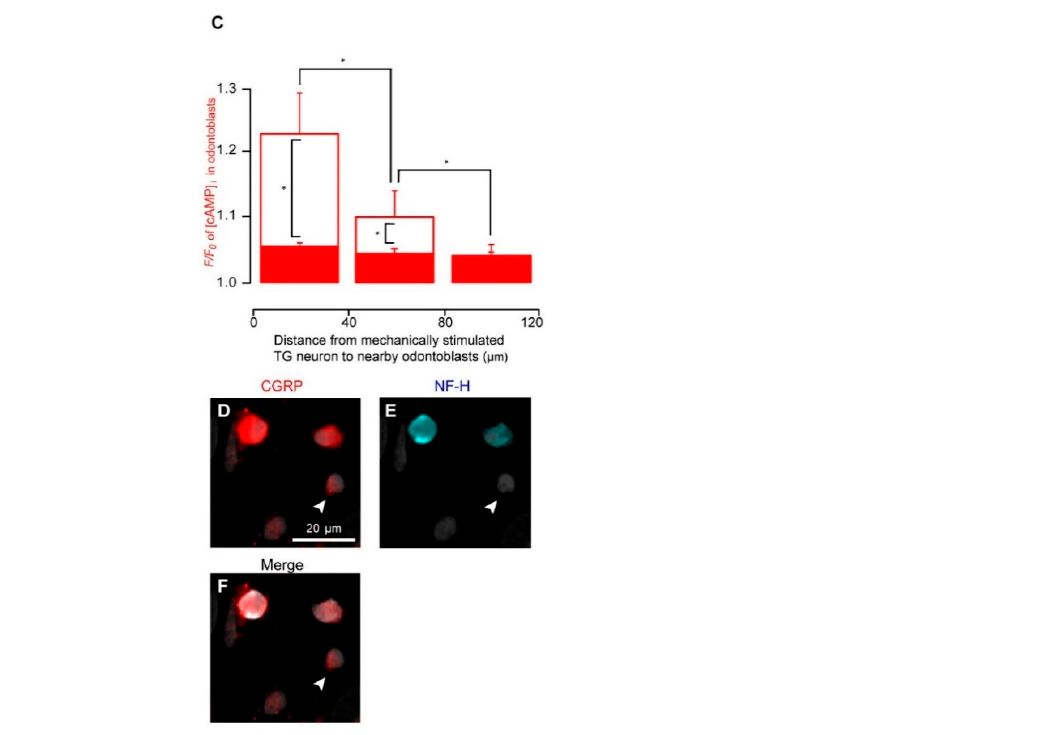
Figure 5. Direct mechanical stimulation of TG neurons simultaneously increases [Ca 2+ ] i in neu- rons and [cAMP] i in the neighboring odontoblasts. ( A , B ) Representative traces showing transiently increased [Ca 2+ ] i in a mechanically stimulated TG neuron (green lines) and [cAMP] i level in neigh- boring odontoblasts (red lines) following focal and direct mechanical stimulation by a micropipette under standard extracellular solution. The traces shown are without ( A ) or with 0.1 nM BIBN 4096 ( B ). Horizontal dotted lines indicate the baseline ( F / F 0 = 1.0) for each response, while vertical dotted lines represent the application time of the mechanical stimulation. The black boxes at the top show the timing of the mechanical stimulation based on the displacement of a micropipette to a depth of 8 µ m. The responses from the nearby odontoblasts were recorded from cells located 0–120 µ m away from the stimulated TG neuron. The distance of each cell from the mechanically stimulated TG neuron is indicated on the right side of each trace ( C ). The F / F 0 values of neighboring odontoblasts located within 0–40 µ m, 41–80 µ m, and 81–120 µ m from the stimulated TG neuron in standard extracellular solution (open columns) or standard extracellular solution with BIBN 4096 (0.1 nM) (red columns) are given. The [cAMP] i increases in the neighboring odontoblasts reduced with the increase in their dis- tance from the mechanically stimulated TG neuron with and without BIBN 4096. Each bar denotes the mean ± SE. Asterisks denote statistically significant differences between columns or values (shown by solid lines): * p < 0.05. ( D – F ) Mechanically stimulated TG neuron showing positive immunoreactivity for CGRP ( D , F ) and negative immunoreactivity for NF-H ( E , F ). Nuclei are indicated by a gray color. Scale bar: 20 µ m. Arrowheads indicate a mechanically stimulated cell. No fluorescence was detected in the negative controls (not shown). Data were obtained using a 120 × magnification objective lens under a microscope. Enlarged images are shown as representative